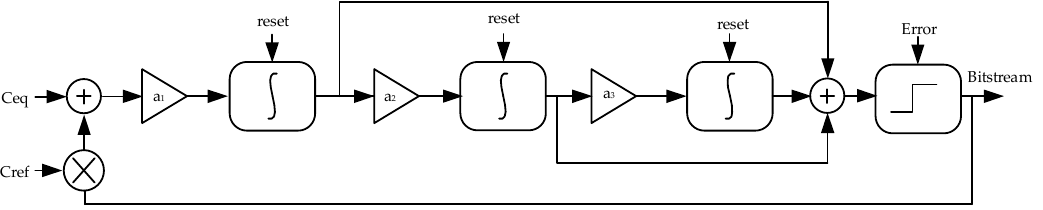
Figure 5. Third-order cascade of integrators with a feed-forward (CIFF) modulator structure and the main signal flow.